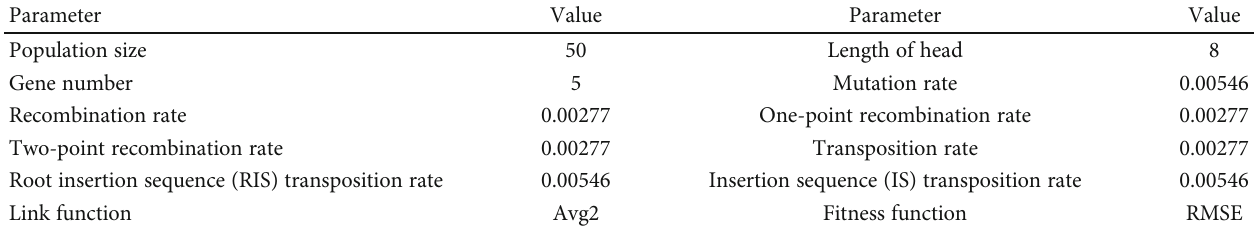
Table 1: Experimental parameters of EP-GEP.